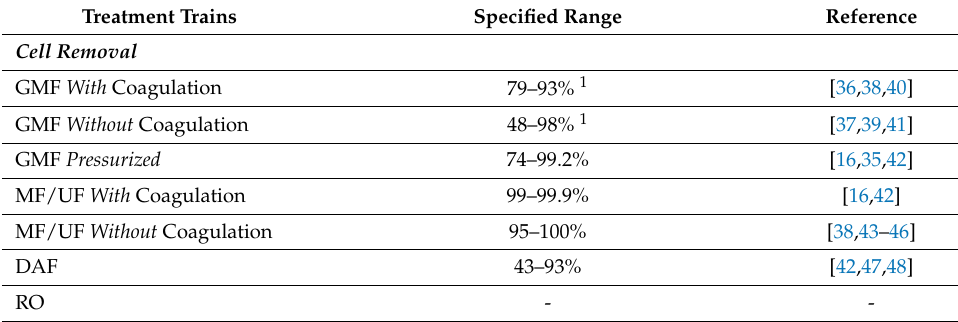
Table 2. Intracellular and dissolved toxin removal efficiencies used in the pMFA